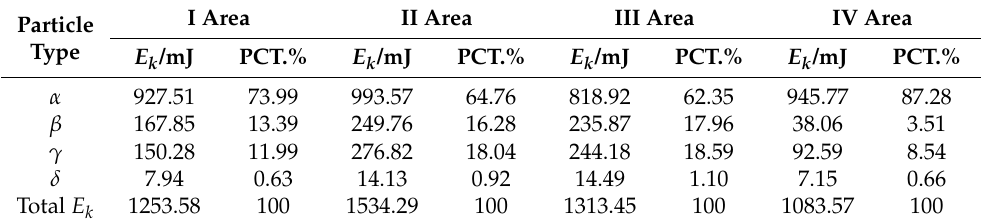
Table 5. Fragments kinetic energy in different areas of specimen 11.